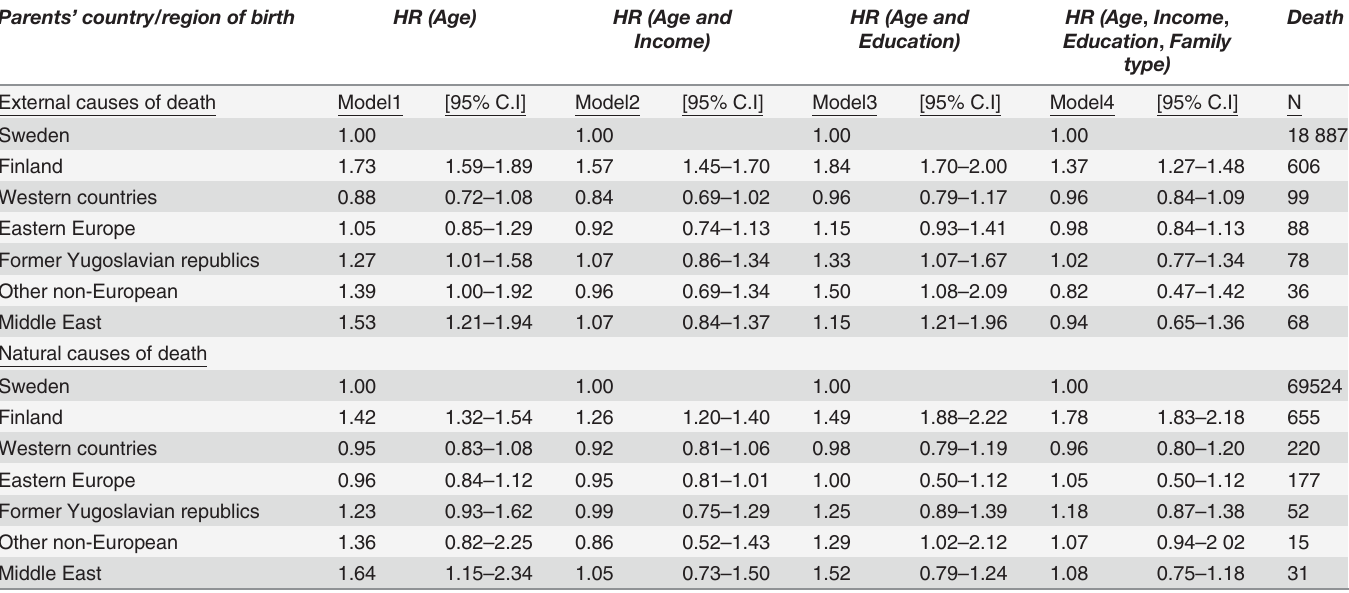
Table 4. Hazard ratios (HR) of mortality from external and natural causes in offspring of immigrants in Sweden, 1990 – 2008 (MEN). Parents ’ country/region of